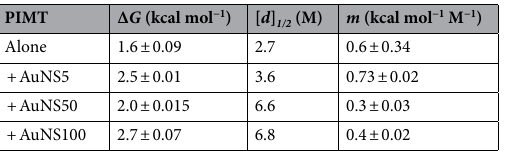
Table 1. Parameters obtained from urea induced unfolding of PIMT alone and in presence of AuNSs.